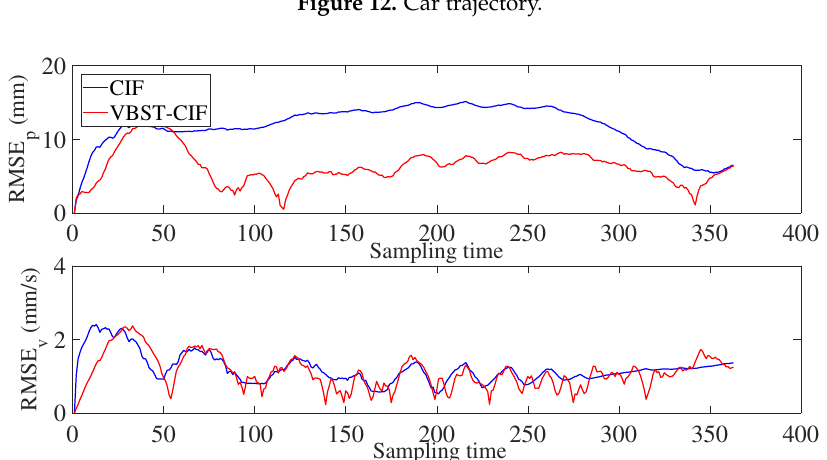
Figure 12. Car trajectory.